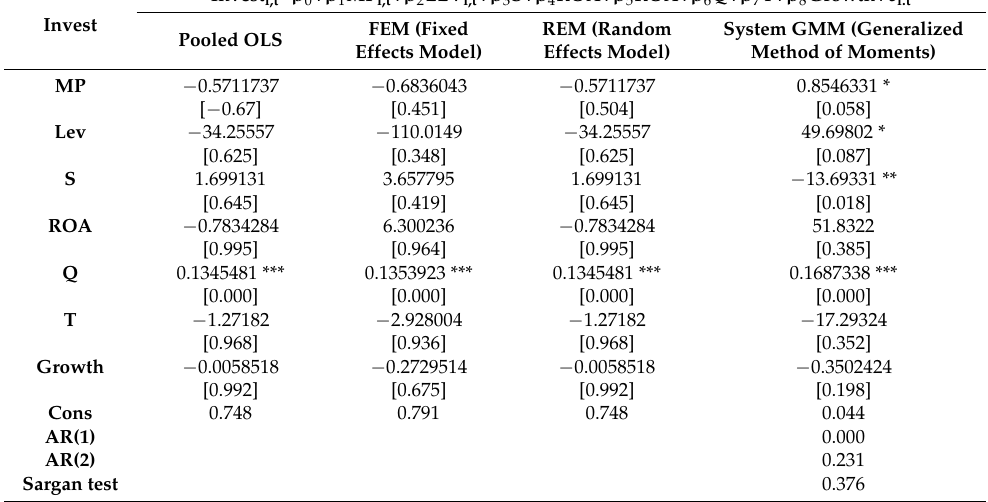
Table 3. Results of the regression model of the impact of monetary expansion policy on corporate investment (Model